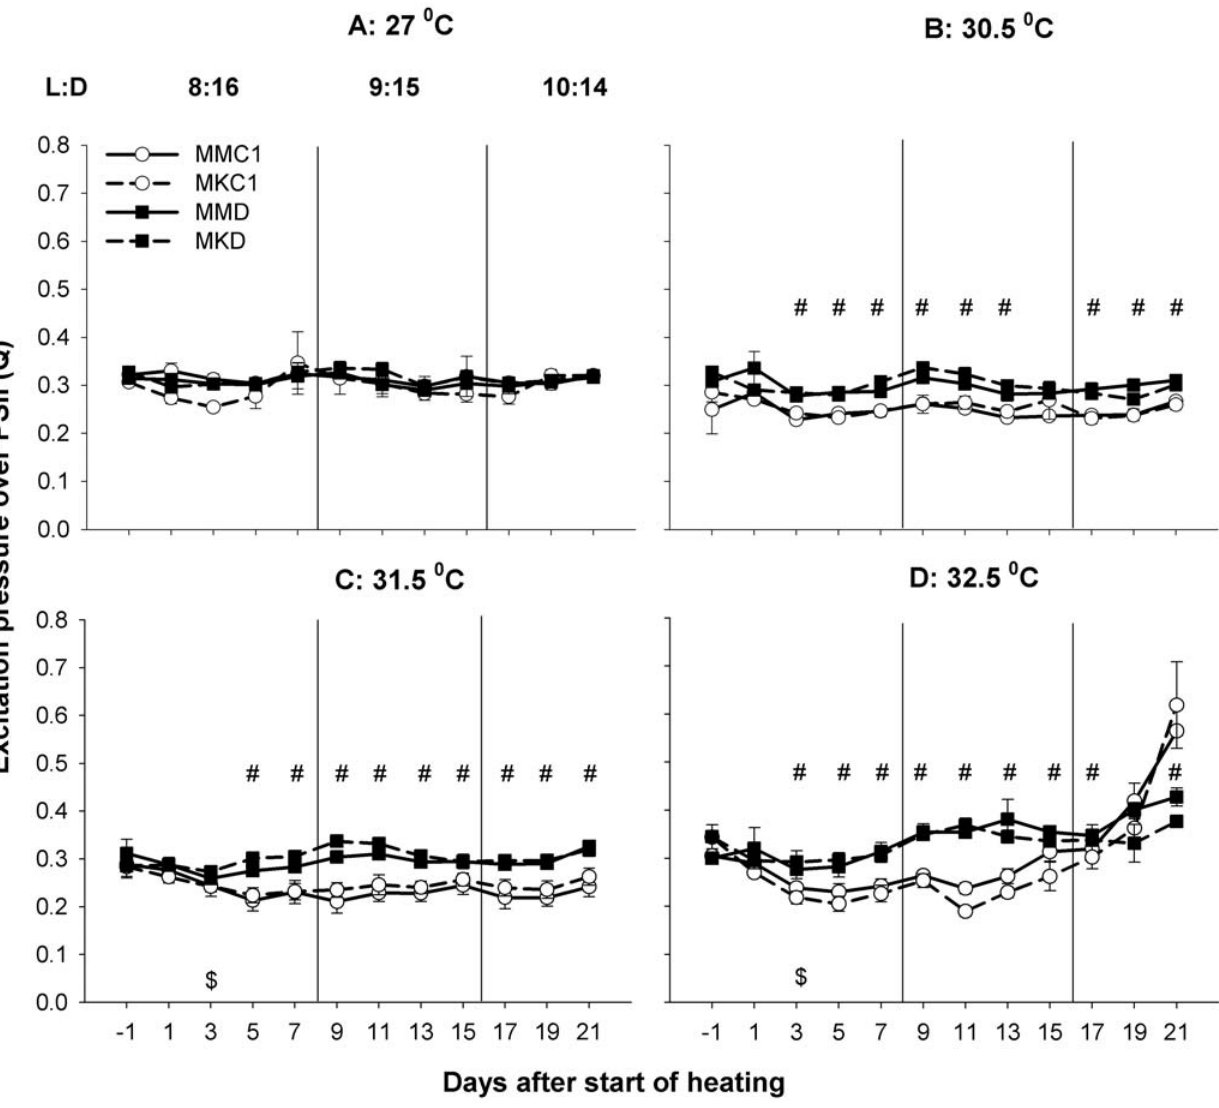
Figure 2. Heat-stress experiment 1: PAM-fluorometry. Effect of four different temperature regimes on the excitation pressure over photosystem II of four groups of juvenile coral outplanted to Magnetic Island. See materials and methods for nomenclature. L:D=light-dark regime, $=target temperature is reached, # =significant difference between C1 corals and D corals. C1 corals responded stronger to the highest temperature treatment than D corals, as indicated by a stronger increase in Q for C1 corals towards the end of the experiment.